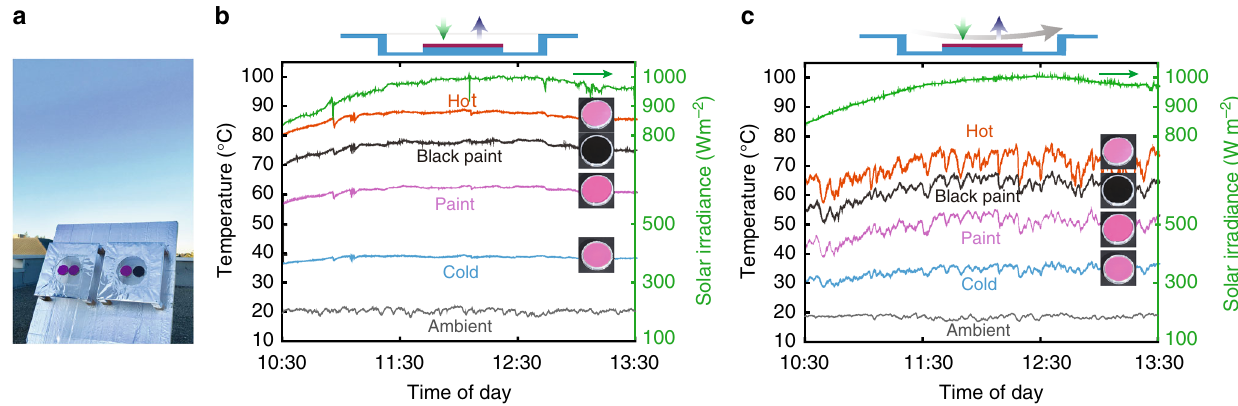
Fig. 4 Outdoor temperature performances of two photonic structures with same colour. a Photo of the temperature measurement apparatus on the test rooftop in Stanford, California. b Rooftop temperature measurements of the ‘ cold ’ (blue), ‘ hot ’ sample (red), a pink paint with similar colour (light purple) as well as a black paint (black), ambient air temperature (light grey), and solar irradiance (green) on a clear fall day in Stanford, California. In this measurement, a low-density polyethene fi lm covers the apparatus to reduce the air convection effect, as shown in top schematic. c Rooftop temperature measurements of the same samples as Fig. 4b but allowing free air fl ow convection, to mimic the typical outdoor condition, as shown in top